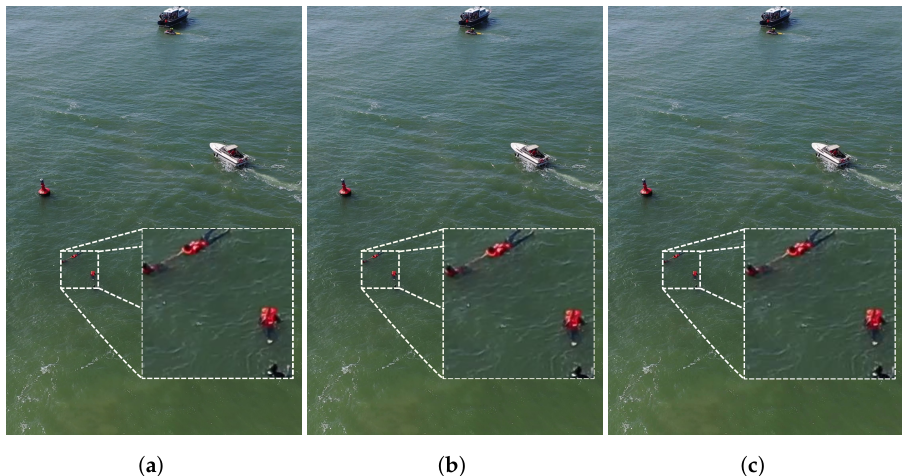
Figure 2. Example images for Compression. ( a ) No comp.; ( b ) 90 comp. quality; ( c ) 70 comp.